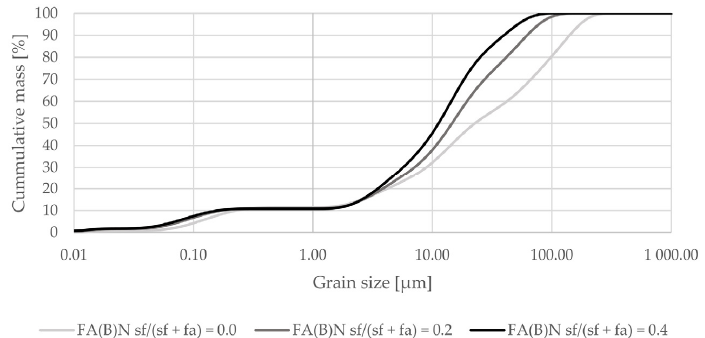
Figure 2. Grain-size distribution of fly ash activated by 20% or 40% of silica fume compared to the grain-size distribution of untreated fly ash (logarithmic